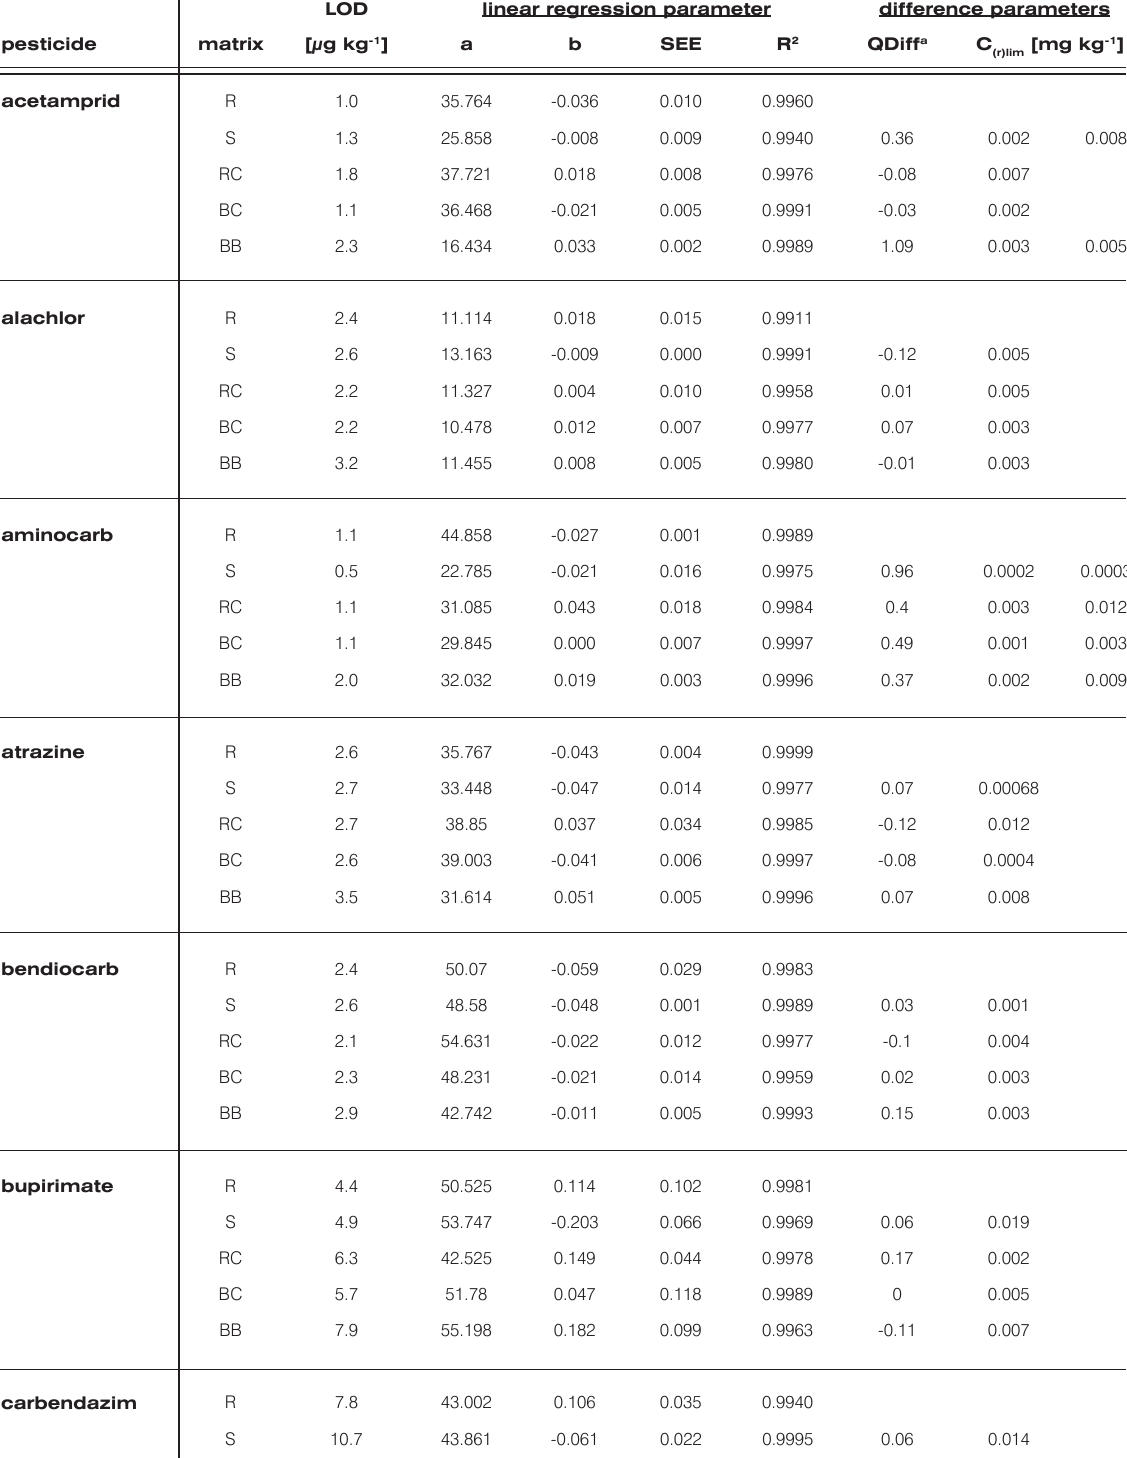
LOD linear regression parameter difference